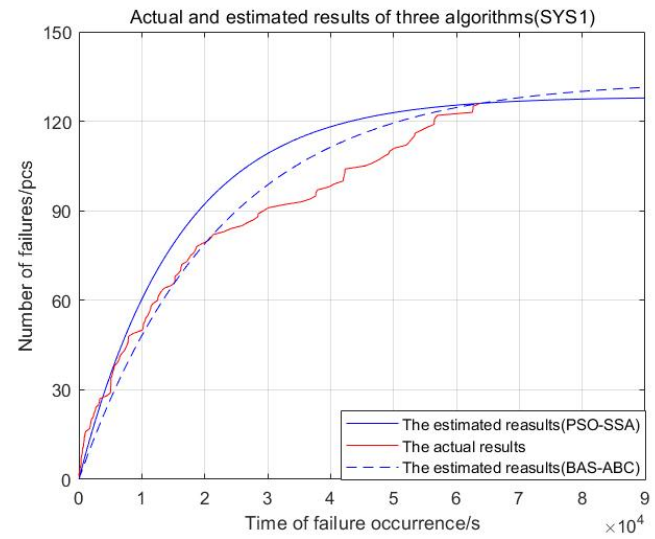
Figure 18. Actual and estimated results of two algorithms (SYS1).